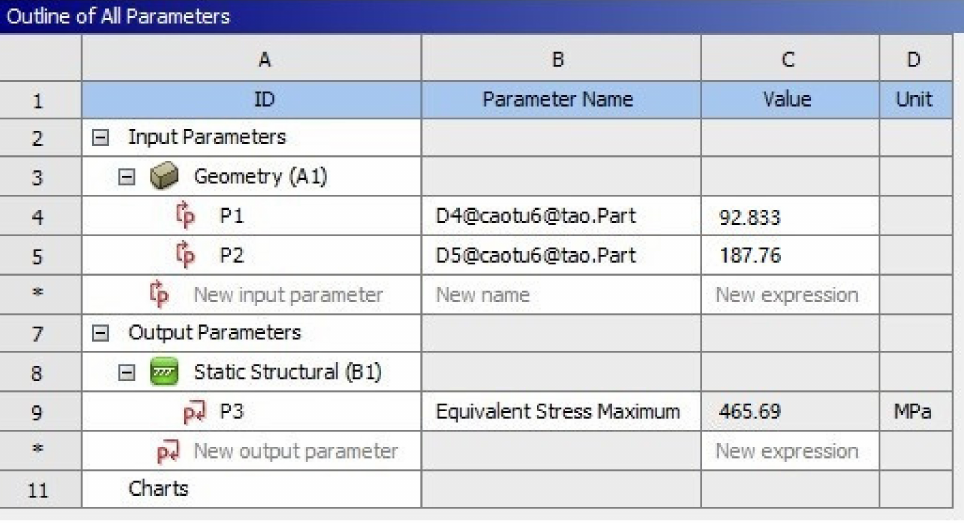
Figure 17. The stress value P 3 corresponding to P 1 and P 2 .